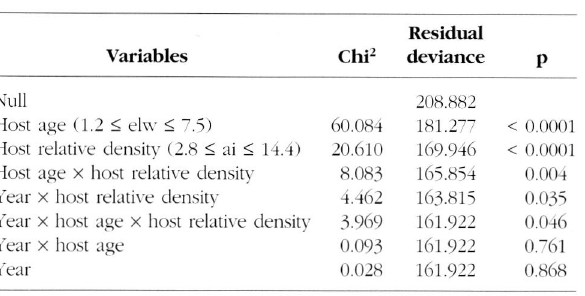
Table III. - Logistic regression results for Frenkelia microti infection in Microtus arvalis